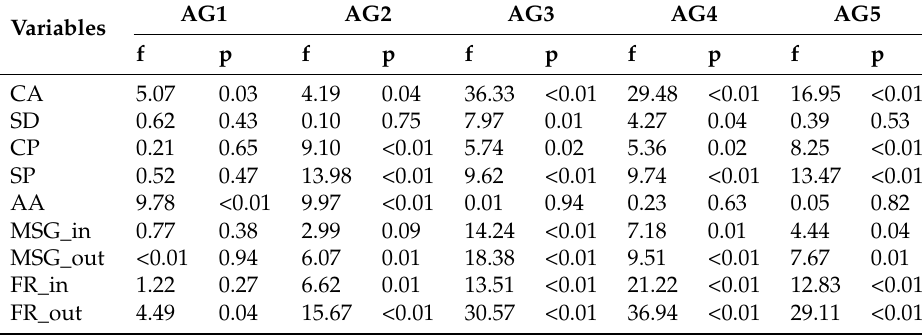
Table 3. Results of regression analysis showing how Activity Factors and Experience Factors are affecting user assignment to adoption